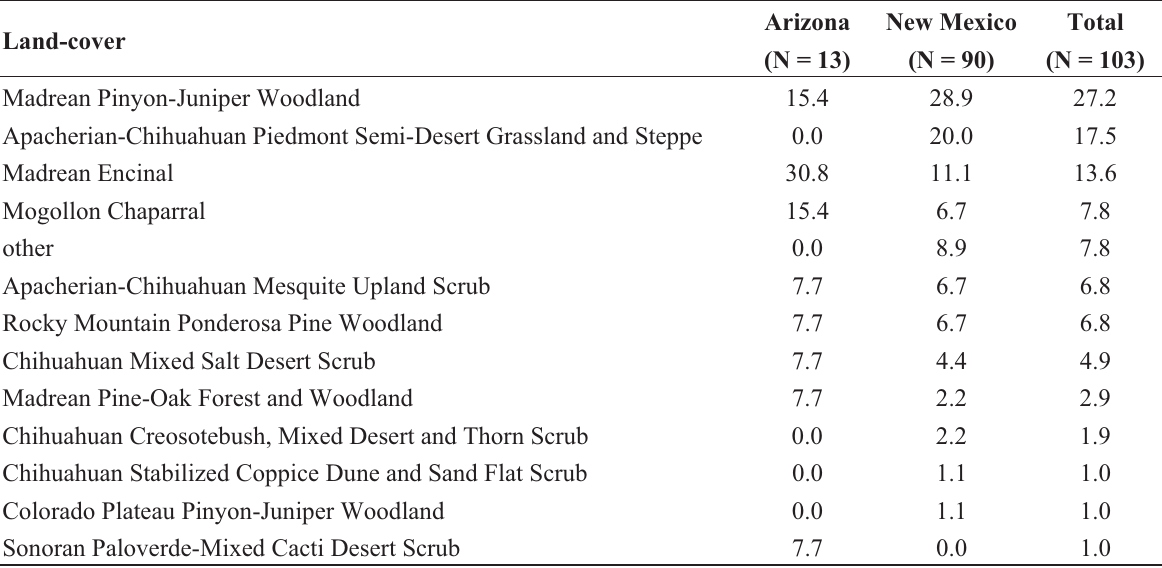
Table 6. Percent of observations of bands of white-nosed coati ( Nasua narica ) in various land-cover types in Arizona and New